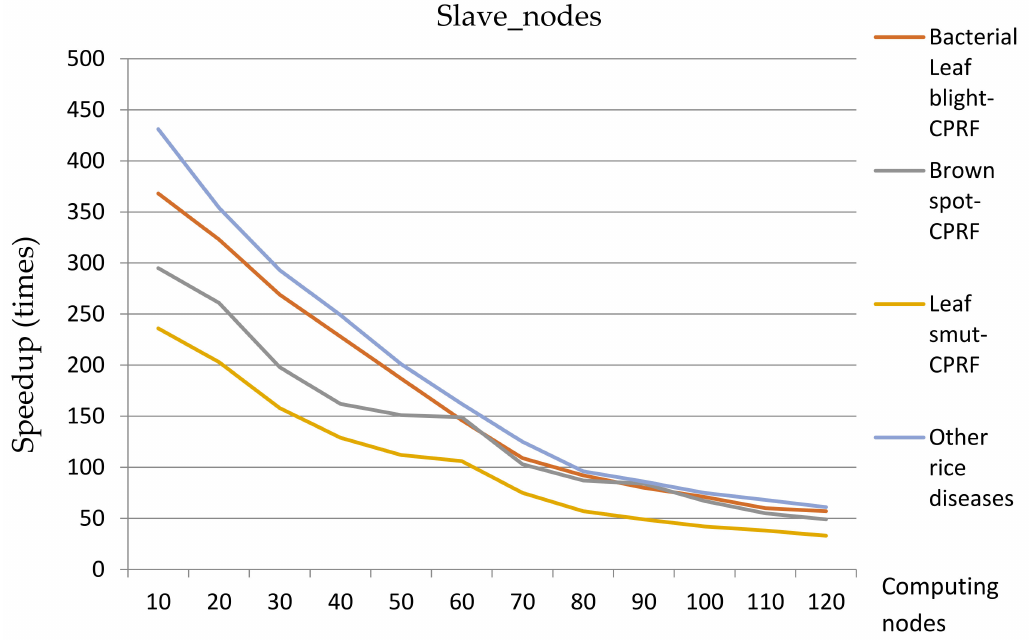
Figure 9. Average execution time of CPRF with different scales of agricultural plant